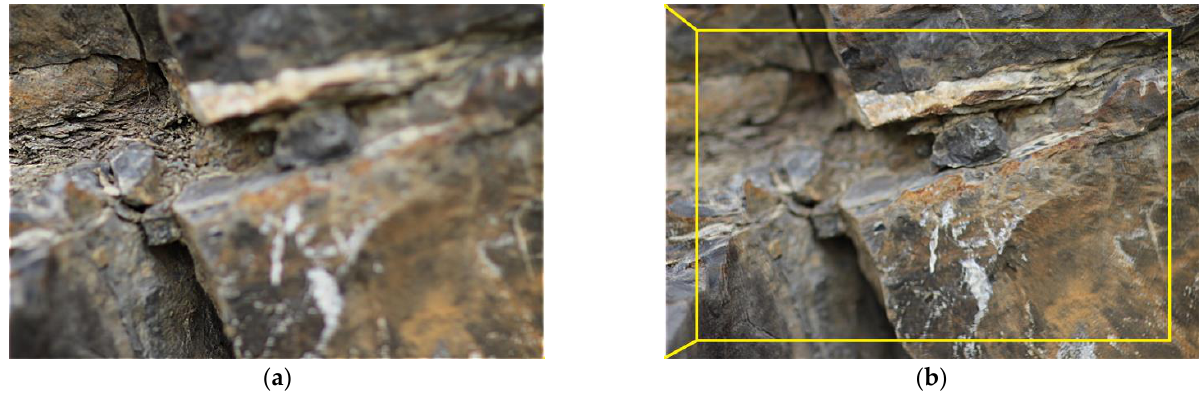
Figure 3. Different scaling and different sharp and non-sharp regions in images acquired by the classic camera positioned at different distances from the 3D relief—the first ( a ) and the fourth ( b ) image of a series of eight images, limestone, locality Brno (Hady, Czech Republic, photo Tomas Ficker). Taken from [26].